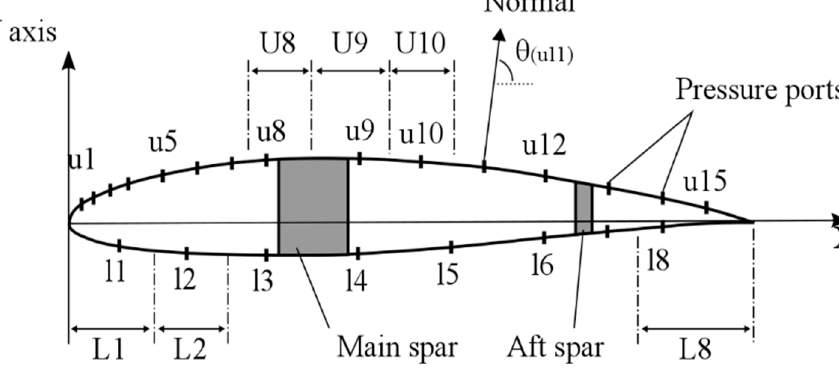
Figure 2. Cross ‐ section of wing model with locations of pressure ports and spars.